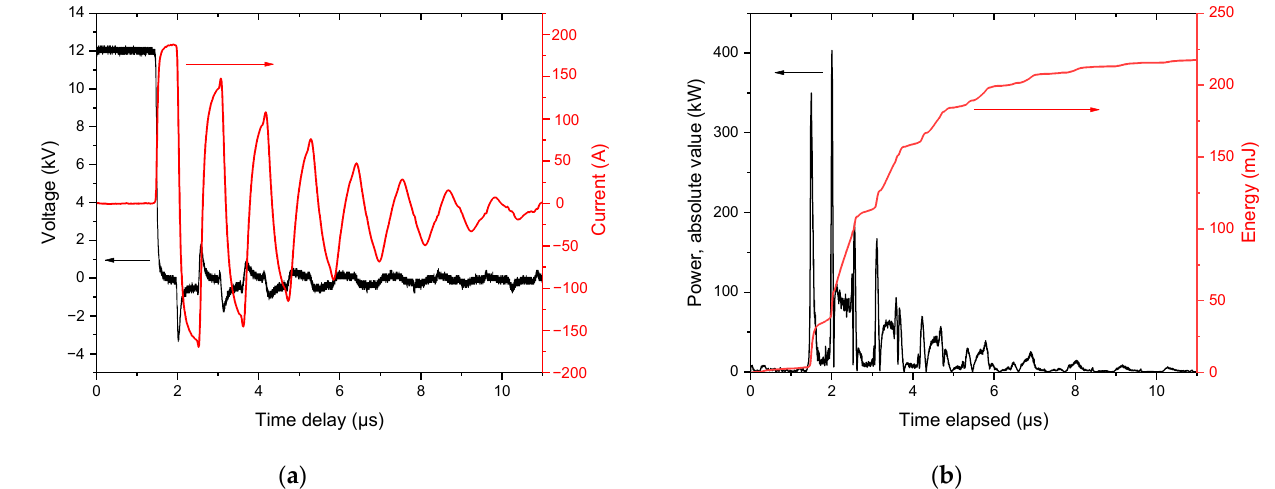
Figure 2. ( a ) Temporal profile of the current and voltage and ( b ) calculated delivered power and energy. Time zero is defined as the laser onset.